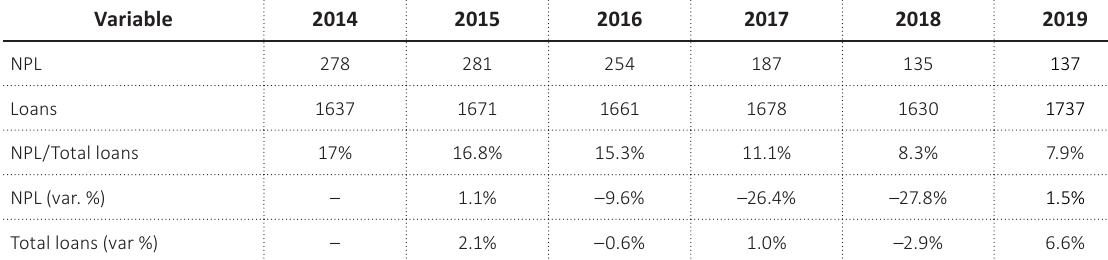
Table A4. Average relative margin of ABS issued on loans of Italian SMEs, weighted by their relative size with respect to the total in the year and proportion of Class A assets on total Source: Authors’ calculations based on European Data Warehouse data.